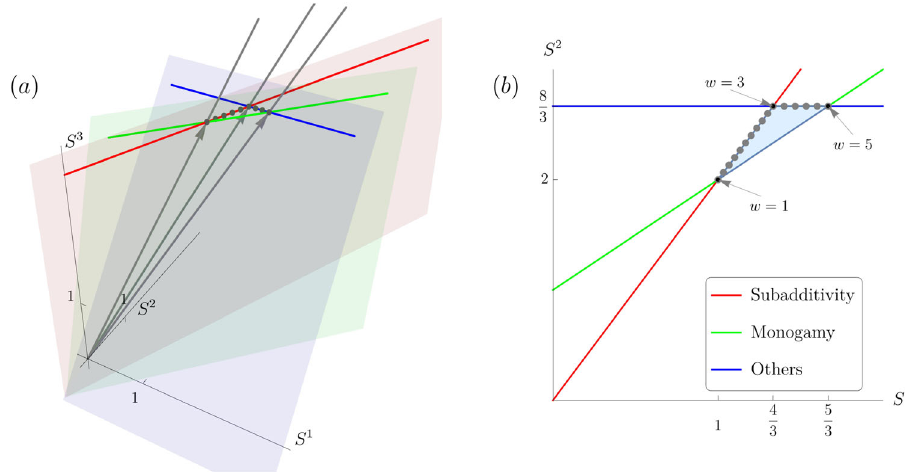
Fig. 2 The N = 5 holographic cone of average entropies. a The cone is bound by three planes in three dimensions, which originate from subadditivity (red), monogamy (green), and other known inequalities (blue). b The S 3 = 3 cross-section of the cone, with the same color scheme.